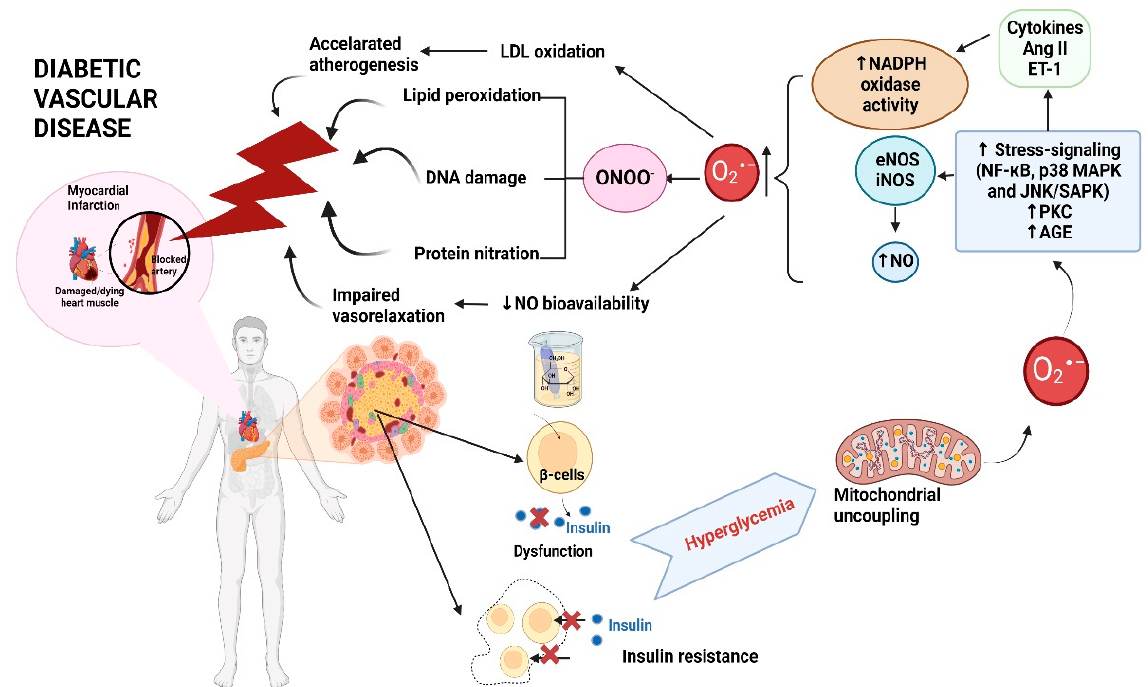
Figure 3. Schematic overview of purposed molecular mechanisms involved in DM and cardiovascular sequelae. AT II, angiotensin II; DM, diabetes mellitus; DNA, deoxyribonucleic acid; ET-1, endothelin 1; eNOS, endothelial nitric oxide synthase; iNOS, inducible nitric oxide synthase; LDL, low-density lipoprotein; NF- κ B, nuclear factor kappa-light-chain-enhancer of activated B cells; ·NO, nitric oxide; O 2· − , superoxide anion radical; p38 MAPK, p38 mitogen-activated protein kinases; ONOO − , peroxynitrite; JNK/SAPK, stress-activated protein kinase/c-Jun NH(2)-terminal kinase. The figure is drawn with Biorender.